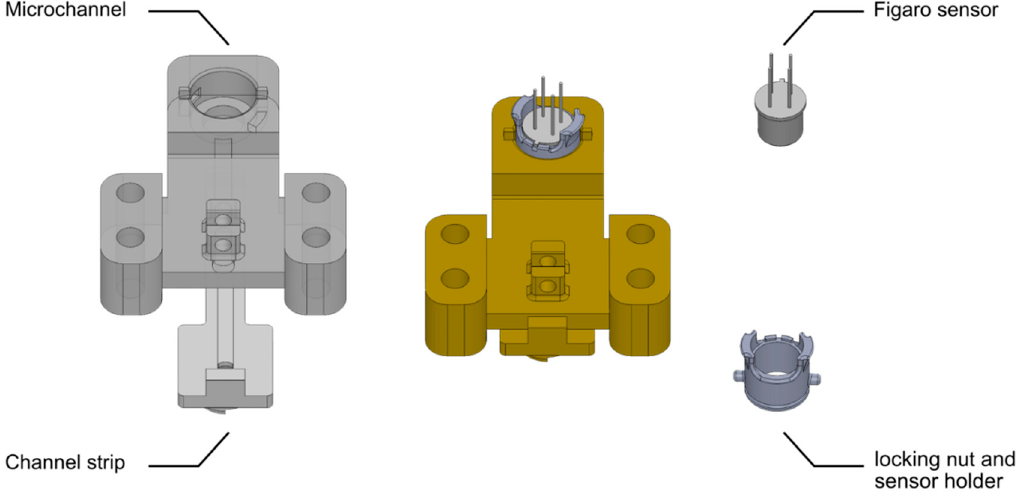
Figure 4. Parts and assembly of the 3D printed microchannel and the modular housing. Table 1. Comparison of select hydrogen and natural gas mixture monitoring platforms by key